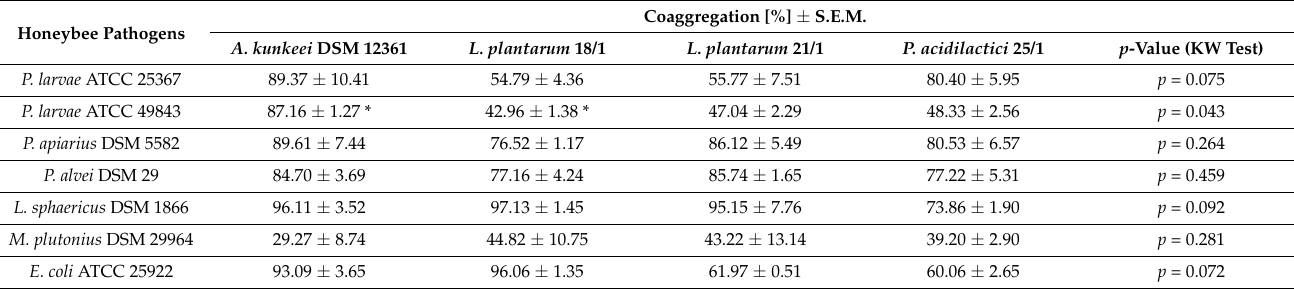
Table 2. Coaggregation [%] of LAB strains with honeybee pathogens after 24 h incubation. The presented results are the mean from three repeats ± standard error of the mean